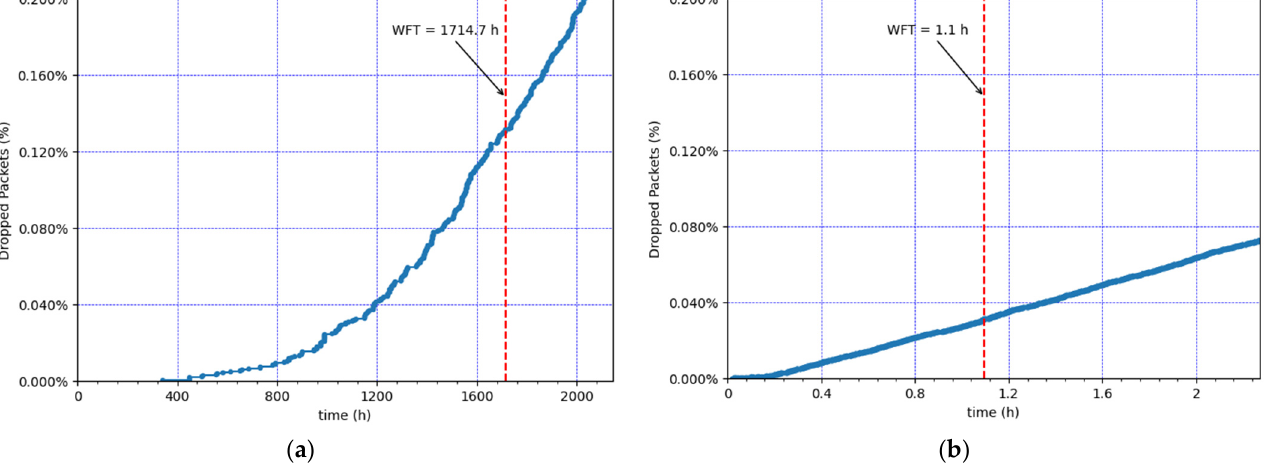
Figure 7. Evolution of cumulative packet drops at the EDs due to duty cycle restrictions over time. ( a ) Lowest load: 30 CEDs, using an EDL of 0.9 packets/h. ( b ) Highest load: 100 CEDs, using an EDL of 18 packets/h.